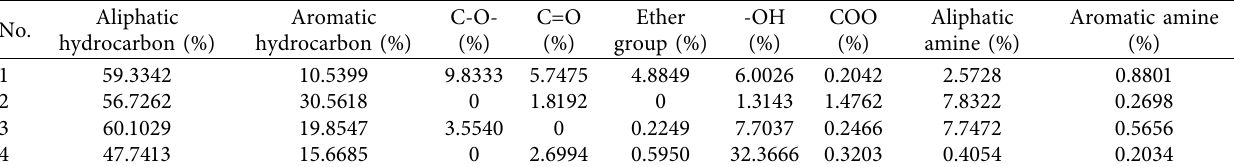
Table 4: Percentages of different functional groups in FTIR spectra of